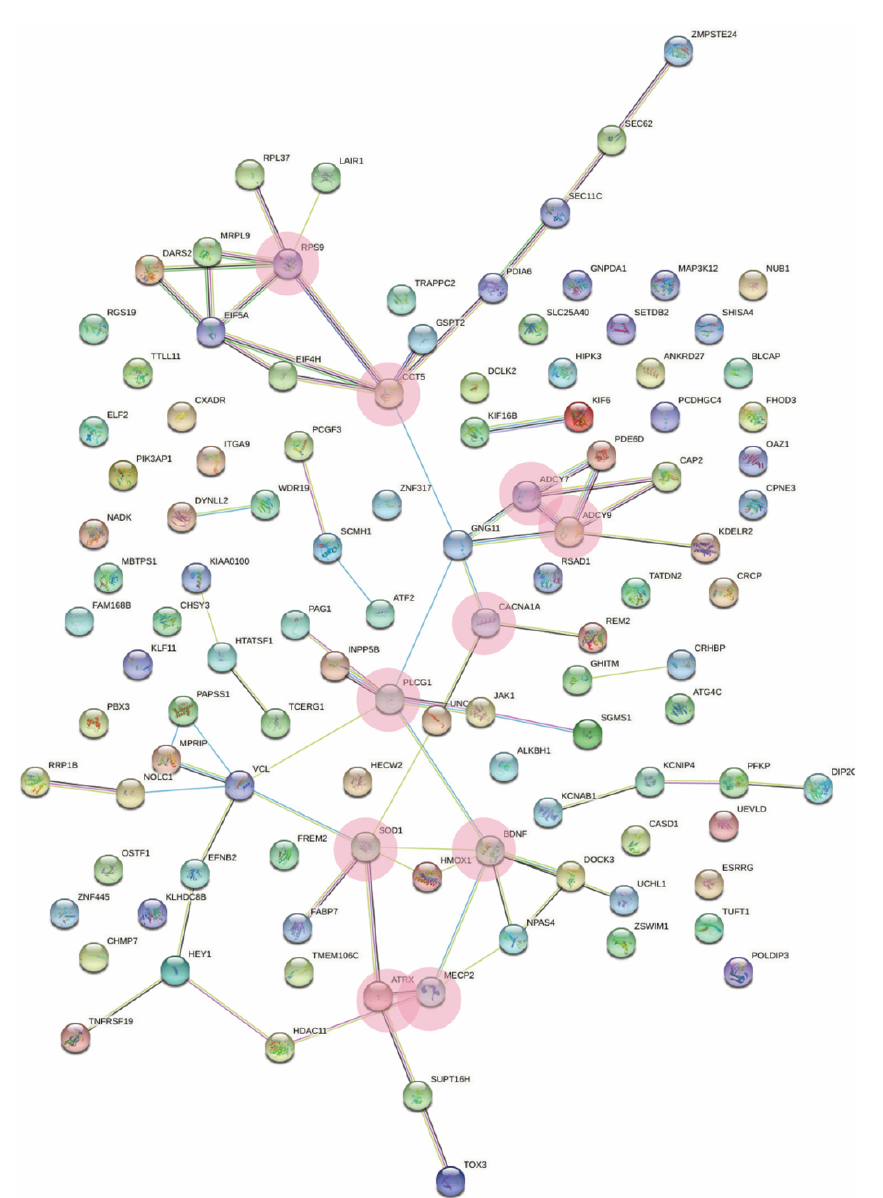
Figure 6. String diagram depicting the gene network of the skyblue module. Pink circles depict the identified hub genes. Table 2. Hub genes and functions. Information adapted from GeneCards.